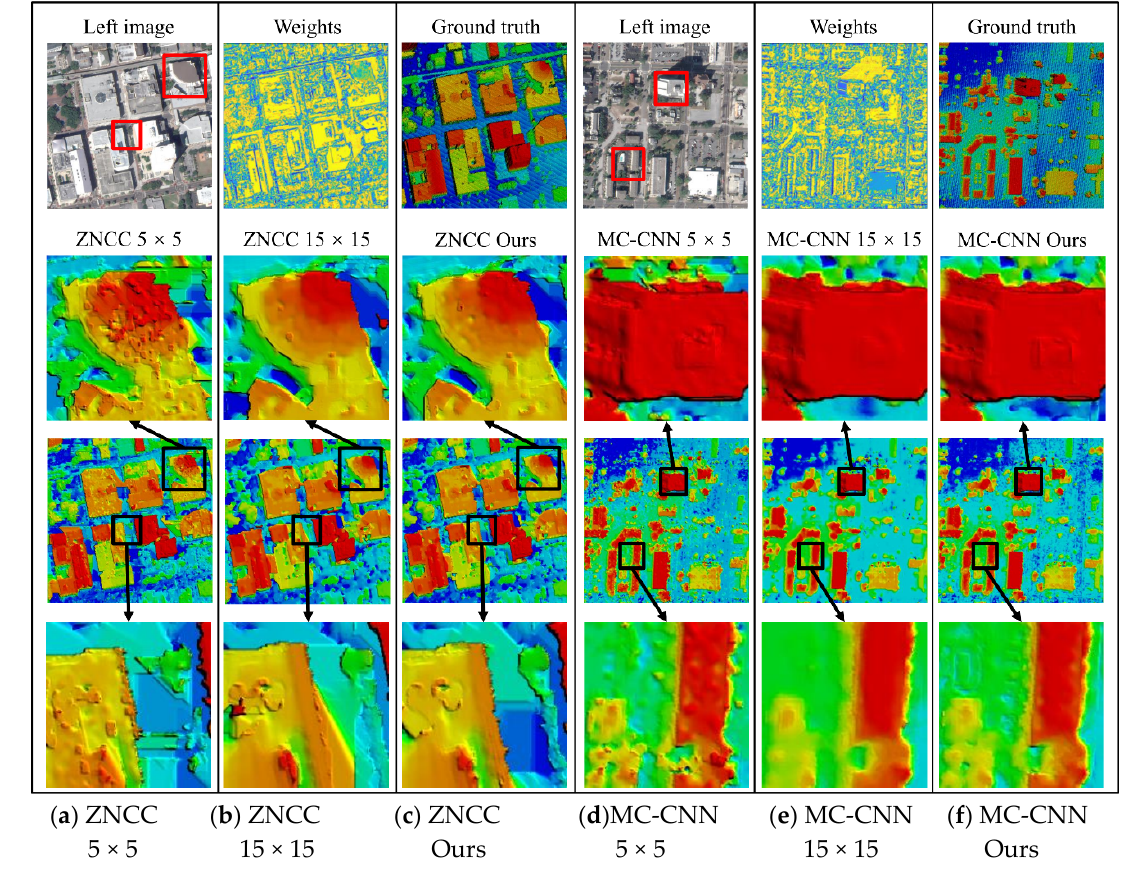
Figure 7. Examples of disparity images on the satellite dataset.